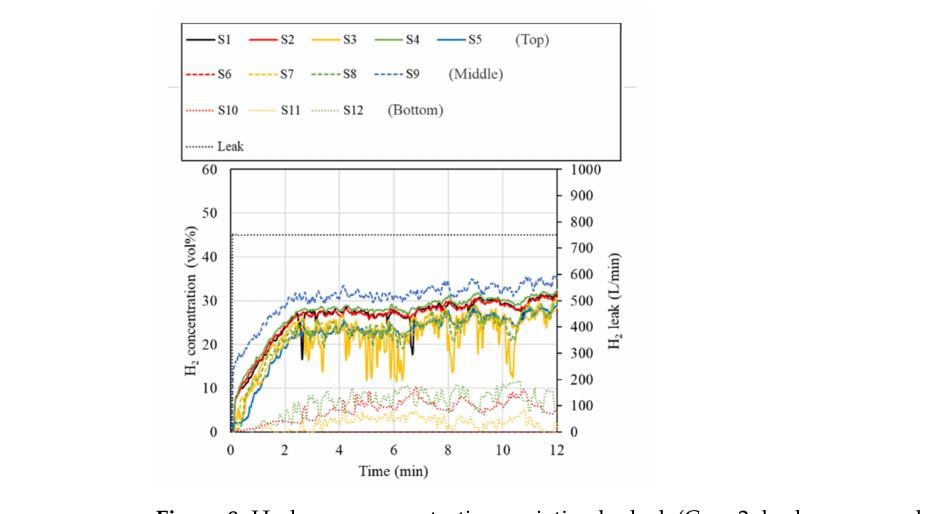
Figure 8. Hydrogen concentration variation by leak (Case 2: hydrogen supply pressure 3 kPa, leak hole 3/8 inch, leak amount 750 L/min, 2 vent openings, and no fan).